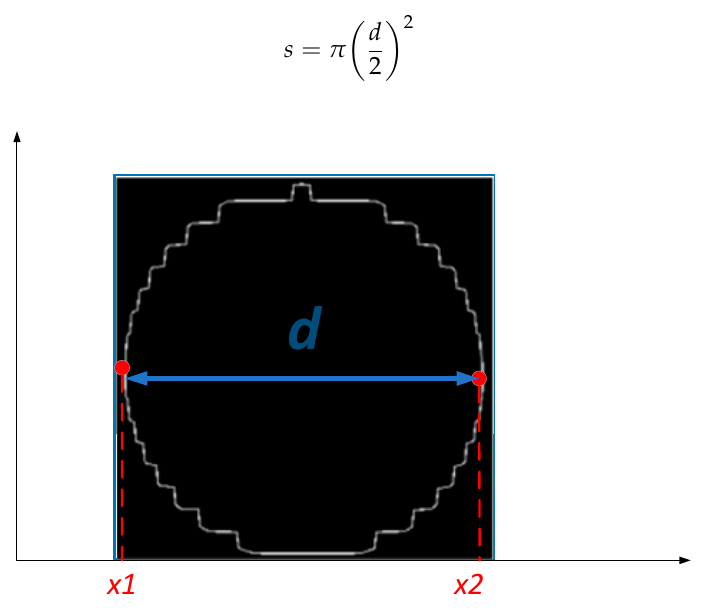
Figure 10. The diameter of LED project.